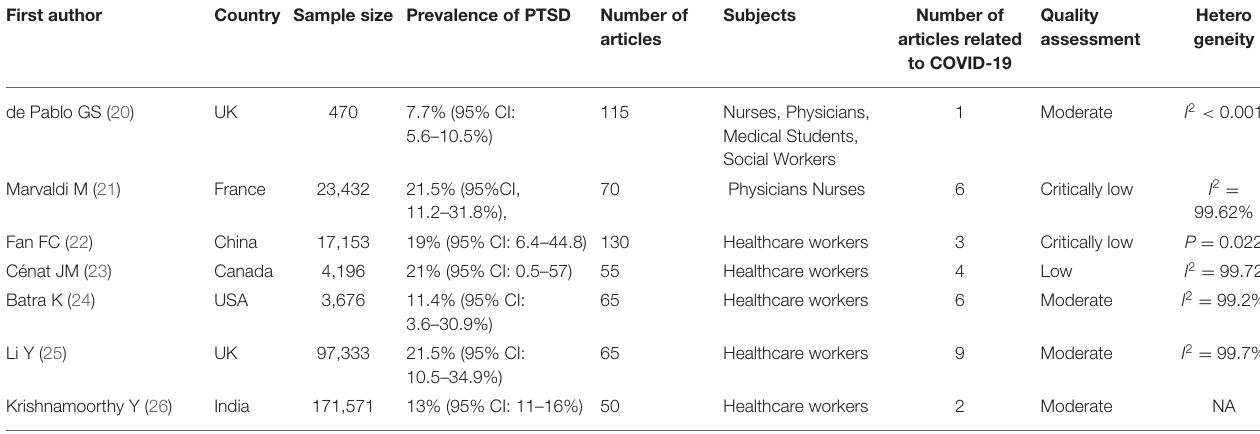
TABLE 2 | Specifications of studies included in the umbrella